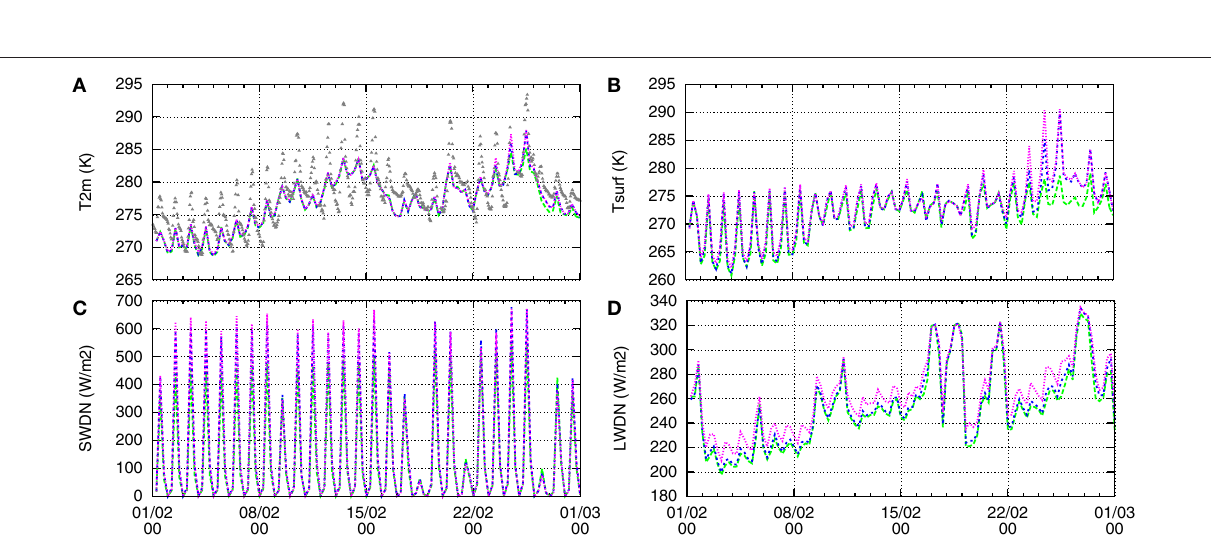
Frontiers in Earth Science |